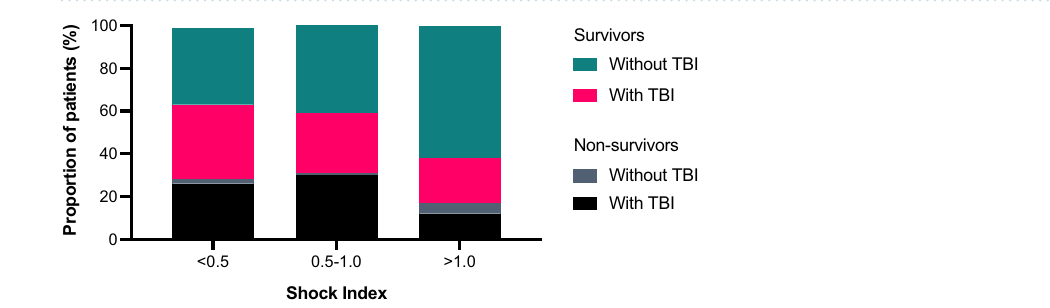
Figure 3. ( A–D ) Area under receiver operator curve (AUROC) of different variations of shock index in all trauma patients, trauma patients without traumatic brain injury, trauma patients with traumatic brain injury, and patients with isolated brain injury. Lines represent 95% confidence intervals. The number of patients varies depending on the amount of missing data needed to calculate specific indexes. TBI, traumatic brain injury; SI, shock index; SS, SI divided by oxygen saturation; SI/G, SI divided by Glasgow Coma Score; SIA/G, SI multiplied by age and divided by Glasgow Coma Score; SIA, SI multiplied by age.